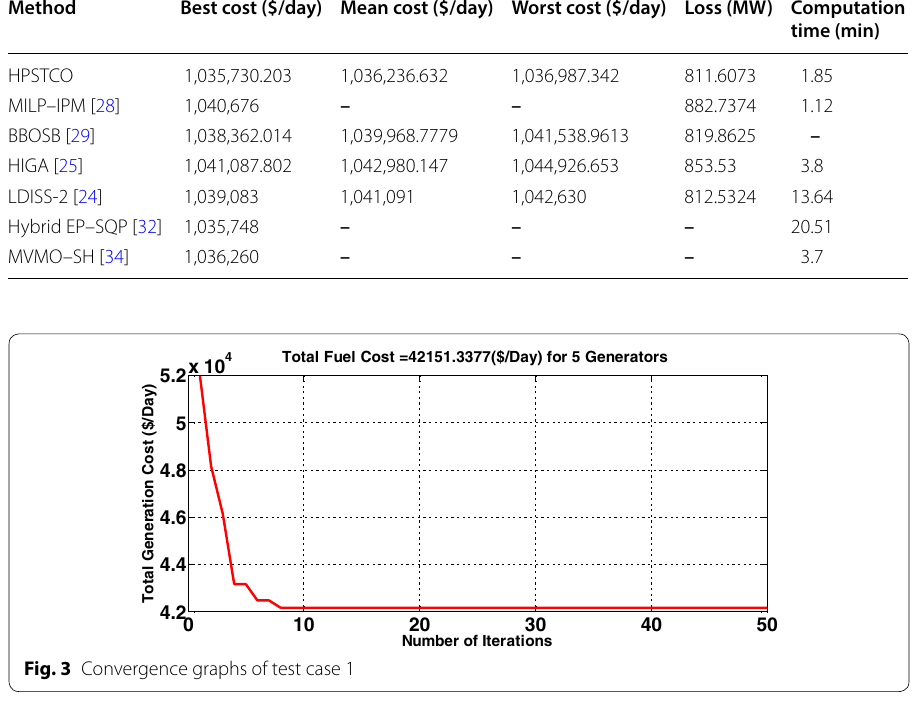
Table 11 Cost and computation time comparison of optimization results in case 2 Method